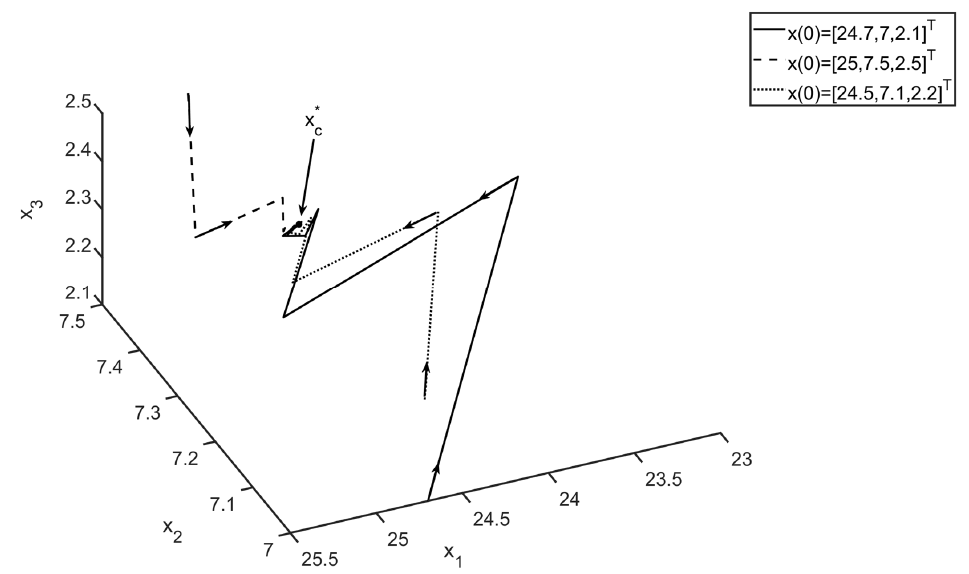
Figure 2. Trajectories tending to the positive equilibrium.